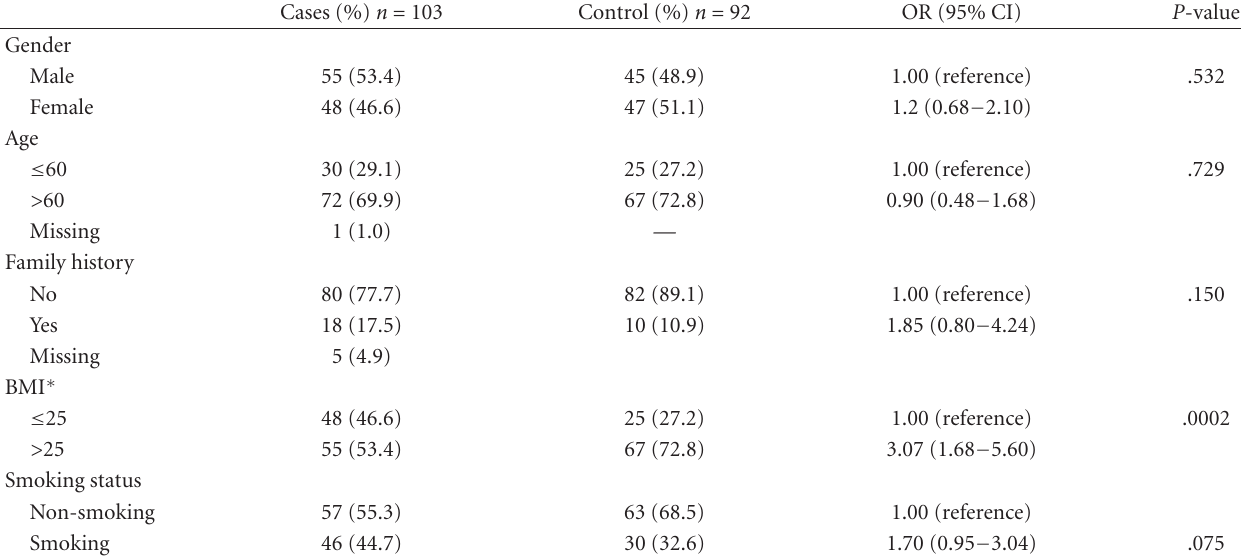
Table 1: Distribution of select characteristics among AP patients and controls.